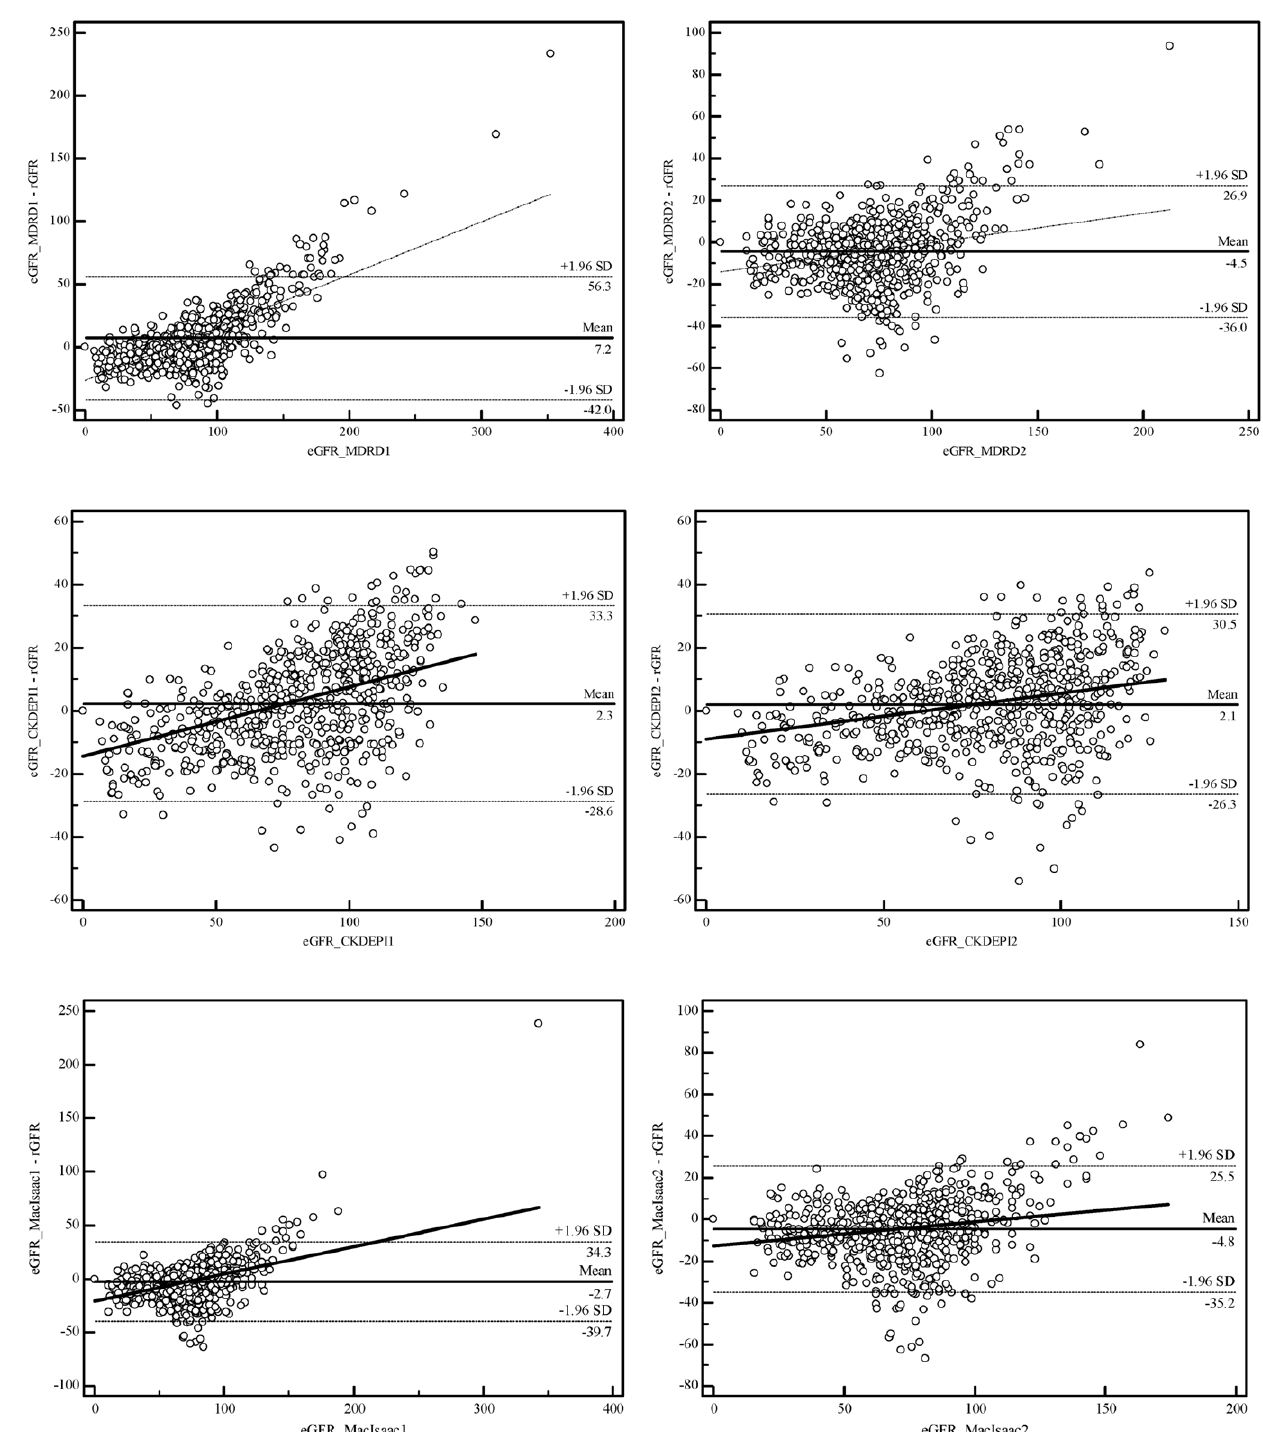
Figure 1. Comparison of agreement of the MDRD, CKD-EPI and MacIsaac equations before and after modification. MDRD: Modification of Diet in Renal Disease; CKD-EPI: Chronic Kidney Disease Epidemiology Collaboration; eGFR: estimated glomerular filtration rate; rGFR: reference glomerular filtration rate; eGFR_MDRD1: eGFR estimated by the original MDRD equation; eGFR_MDRD2: eGFR estimated by the modified MDRD equation. The oblique line represents the regression line of difference between eGFR and rGFR, showing slope and intercept. The solid horizontal line represents arithmetic mean between eGFR and rGFR, and the dotted line represents 95% confidence intervals of the standard deviation.